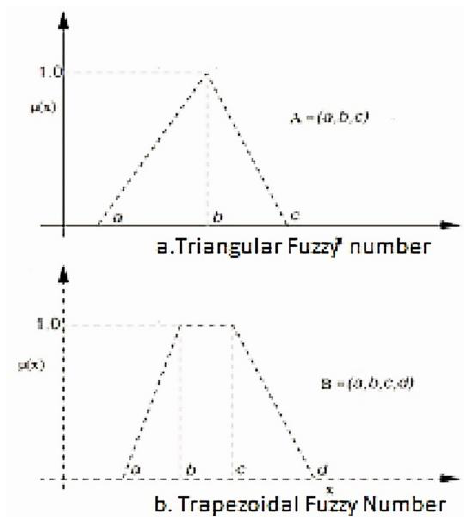
Figure 2. Types of fuzzy